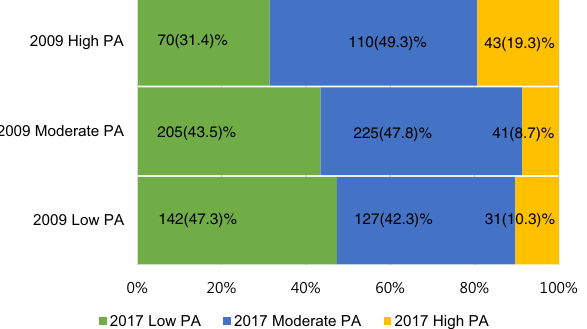
Figure 1. Physical activity (PA) categories in 2009 and 2017.